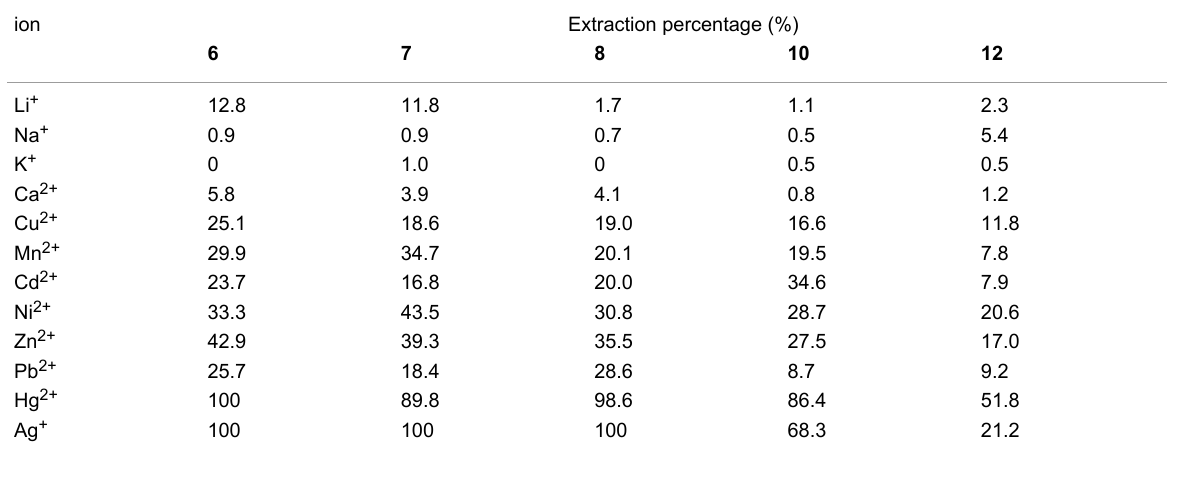
Table 2: The percentage of metal picrates extracted from the aqueous to the organic phase by calixarenes 6 – 8 , 10 , and 12 .